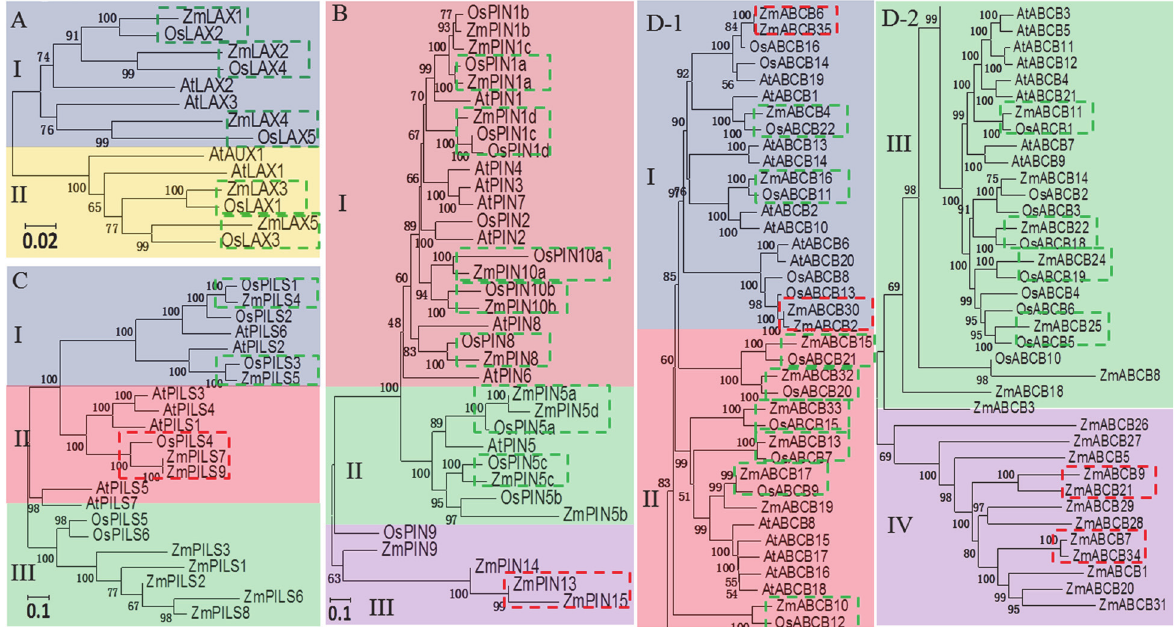
Fig 2. Phylogenetic relationship analysis of auxin transporter family between maize, Arabidopsis and rice. Bootstrap values are presented for all branches. (A) LAX protein family: inventory of AtLAX and OsLAX families is based on TAIR and TIGR rice databases. (B) PIN protein family: sequence data on AtPIN and OsPIN families is based on TAIR annotation and Shen ’ s publish. (C) PILS protein families: inventory of AtPILS and OsPILS families is listed at S1 Table. (D) ABCB protein family: inventory of AtABCB and OsABCB families is based on the ABC superfamily review by Verrier et al . Different colors indicated different subfamilies. The ortholog genes between maize and Arabidopsis or rice were indicated by green dotted boxes. The paralog genes within maize were indicated by red dotted boxes.